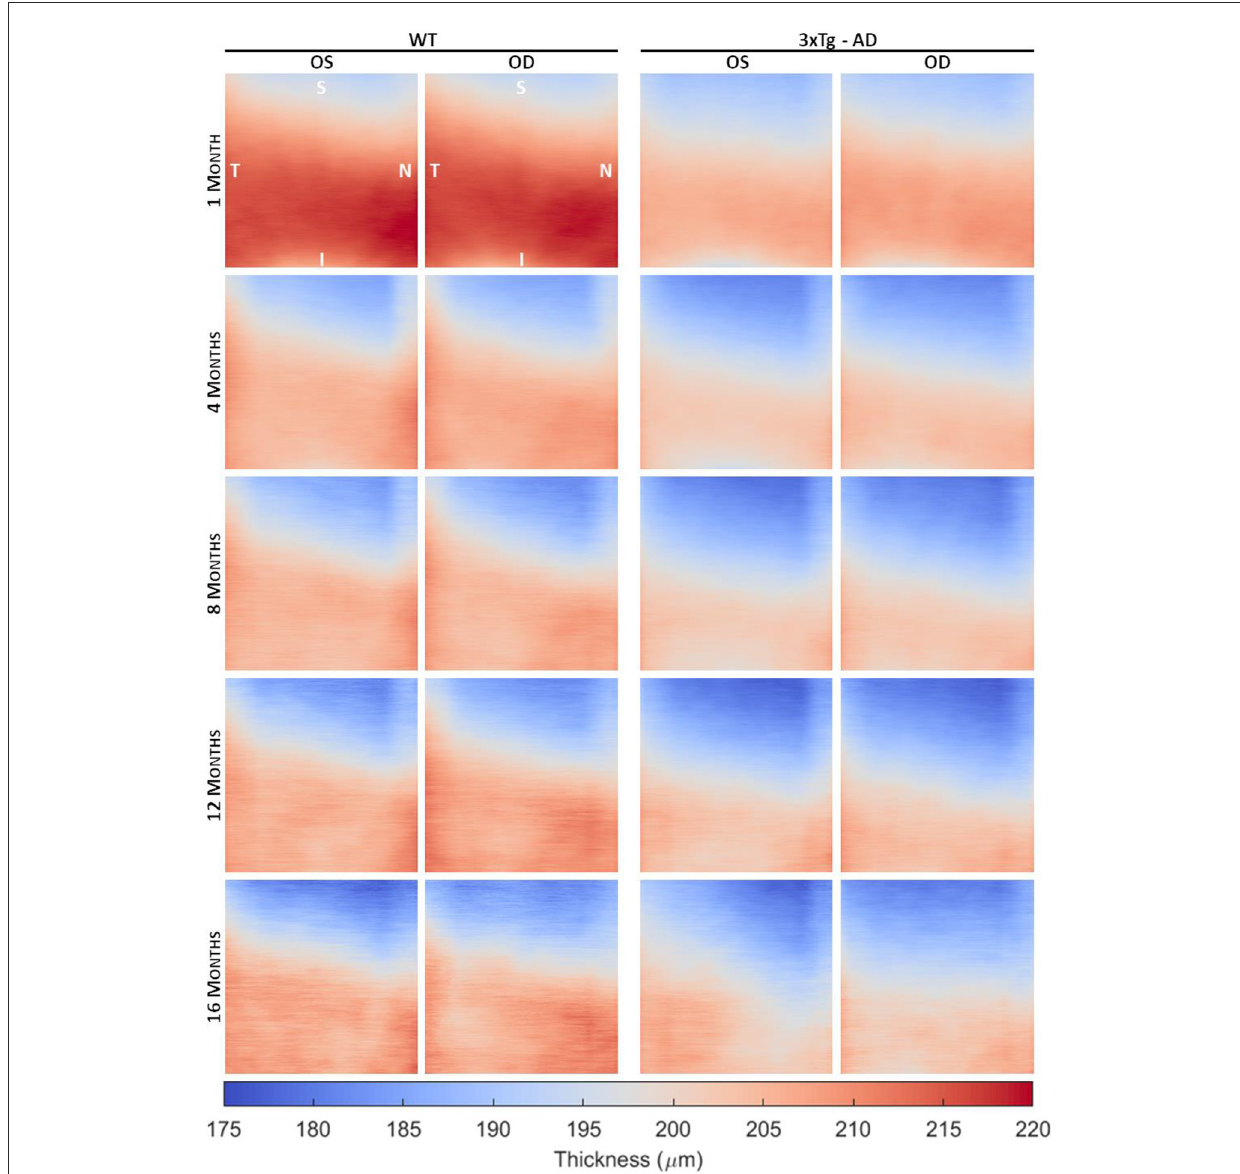
FIGURE2 Average total retinal thickness maps of wild-type (WT) and the triple transgenic mouse model of Alzheimer’s disease (3 × Tg-AD) retinas separated by left (OS) and right (OD) eyes of animals aged 1, 4, 8, 12, and 16 months. Color represents the retinal thickness in µ m as indicated by the color bar. S, superior; I, inferior; T, temporal; N,